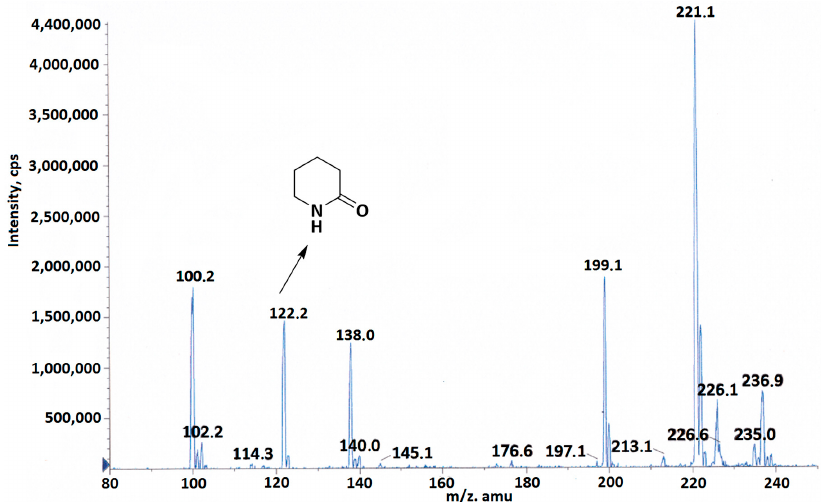
Figure 2. HRMS confirmed formation of piperidin-2-one in the reaction of the compound 1 with NaHS.